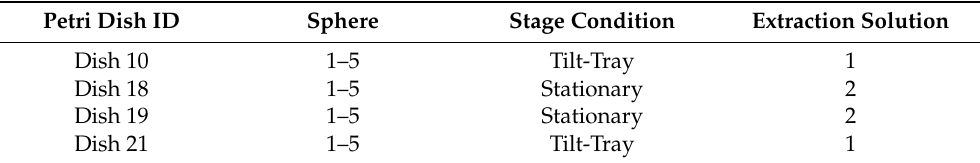
Table 3. Summary of extraction procedure. Dish 10, Dish 21, Dish 18 and Dish 19 were used for this procedure. Extraction time, 24 h, and extraction temperature, room temperature was kept constant for all